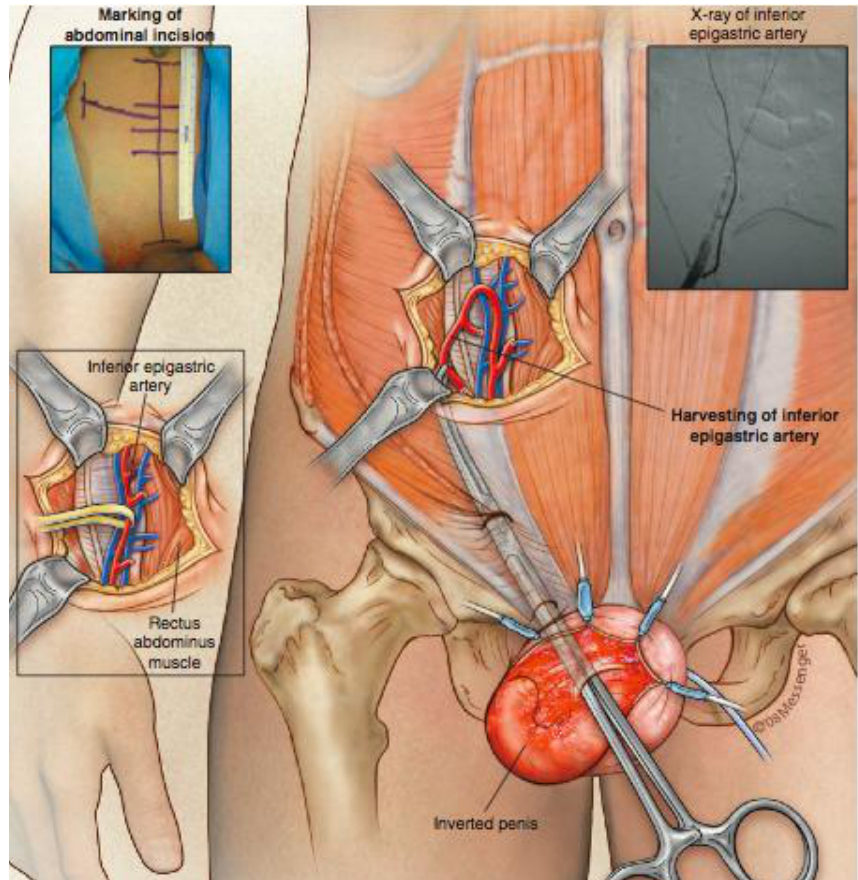
FIGURE 2. Harvesting of the IEA. (From Goldstein, I., Bastuba, M., Lurie, A., and Lubisich, J. [2008] Penile revascularization. J. Sex. Med. 5(9), 2018-2021. With permission.)